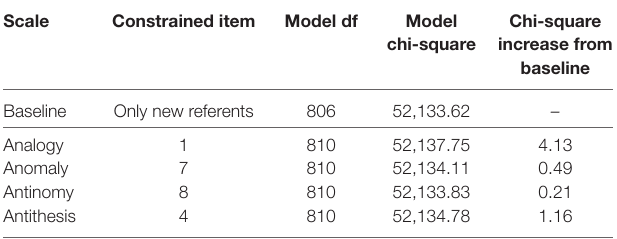
taBlE 3 | Likelihood-ratio tests for differential item functioning between males and females: testing